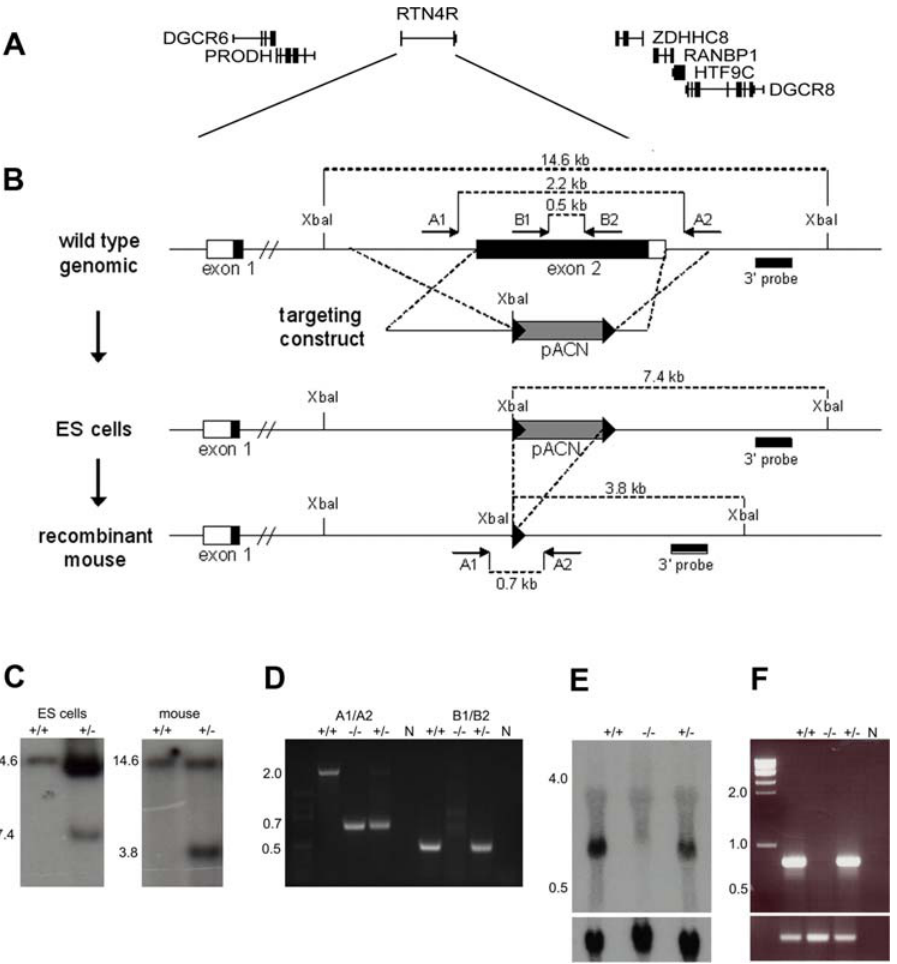
Figure 2. Targeting the Rtn4rlocus for homologous recombination. (A) Gene map of the Rtn4r locus at mouse chromosome 16. (B) Exon II of Rtn4r was replaced by the self-excisable pACN cassette including the neo gene for selection. Genomic DNA was digested with Xba I and the 3 9 probe was used for southern blot analysis. A PCR strategy was designed to genotype offspring using primer sets A1/A2 and B1/B2. (C) Genomic southern blot of ES cell DNA and tail biopsies. Wild-type fragments were 14.6-kb, recombinant fragments from ES cells were 7.4-kb, and recombinant fragments from tail biopsies after pACN cassette excision were 3.8-kb. (D) PCR genotyping of tail biopsies using primer sets A1/A2 and B1/B2. Wild-type mice yielded 2.2-kb and 0.5-kb fragments from sets A1/A2 and B1/B2 respectively; homozygotes yielded 0.7-kb and no fragment, respectively; and heterozygotes yielded 0.7-kb and 0.5-kb fragments, respectively. (E) Northern blot of total brain RNA using a Rtn4r 3 9 UTR probe. (F) RT-PCR of total brain RNA using isoform-specific primers for Rtn4r exon